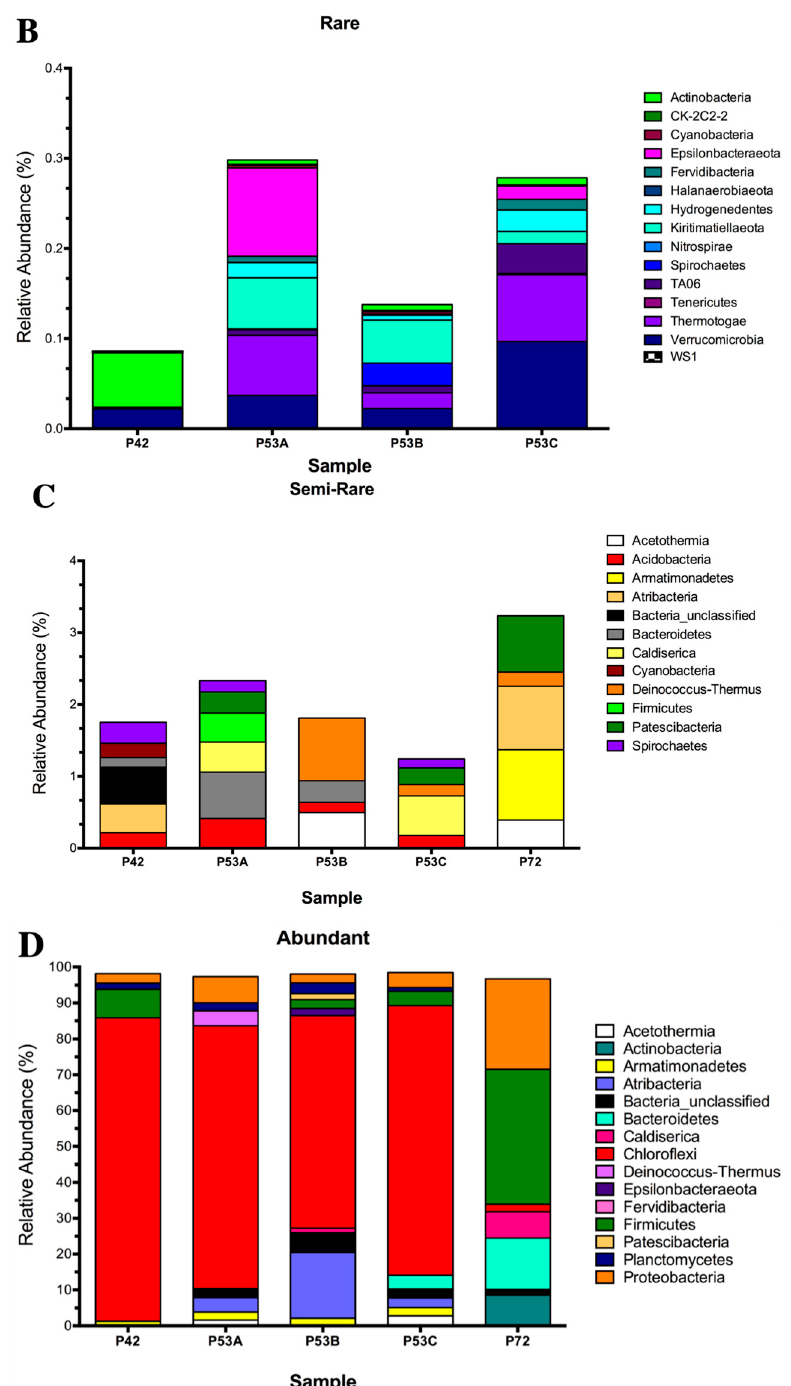
Figure 3. Relative abundance of the 16S rRNA gene metabarcoding analysis that was classified at the phylum level of the microbial community structure from the hot springs at the Lirima hydrothermal system. ( A ) Bacterial diversity of the P42, P53A, P53B, P53C and P72 springs. ( B ) Rare bacterial diversity of the P42, P53A, P53B and P53C springs. ( C ) Semi-rare bacterial diversity of the P42, P53A, P53B, P53C and P72 springs. ( D ) Abundant bacterial diversity of the P42, P53A, P53B, P53C and P72 springs.